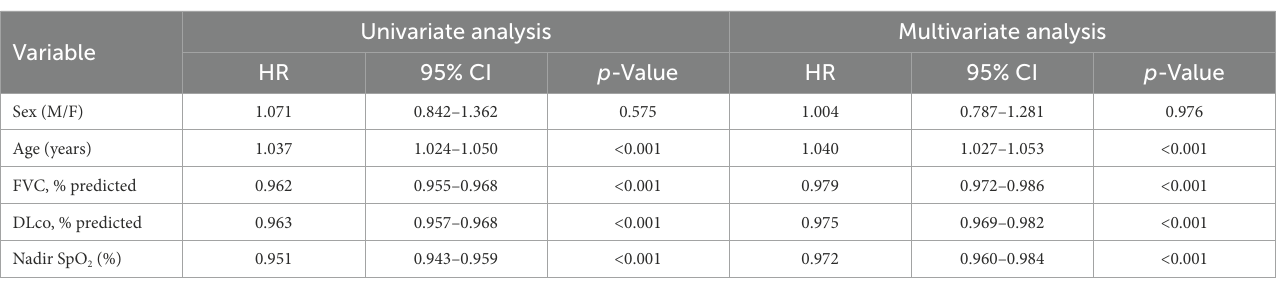
TABLE 3 Survival analysis with Cox proportional hazard